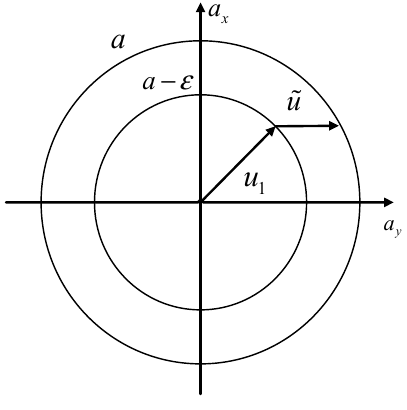
Figure 3. Control variables in friction circle